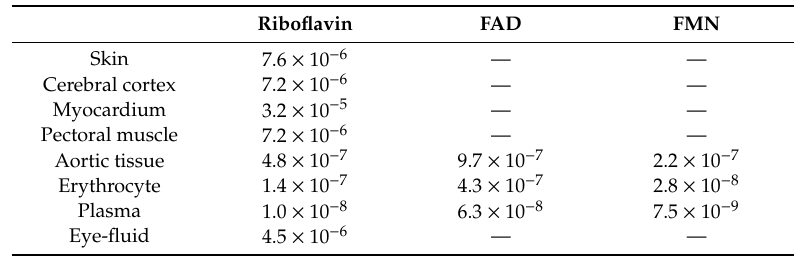
RF is phosphorylated intracellular to flavin mononucleotide (FMN) and further metabolized to flavin adenine dinucleotide (FAD) (Figure 1).